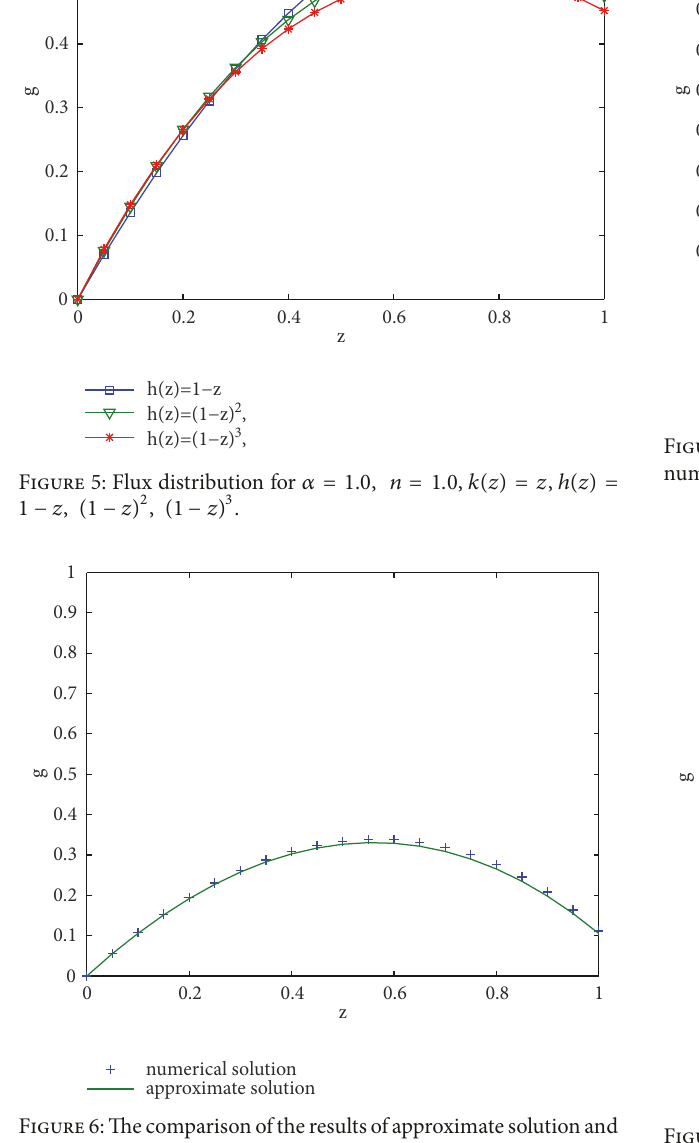
Figure8:Thecomparisonoftheresultsofapproximatesolutionand numerical solution for 𝛼 = 1.0 , 𝑛 = 8.0 , 𝑘(𝑧) = 𝑧 , ℎ(𝑧) = 1 −